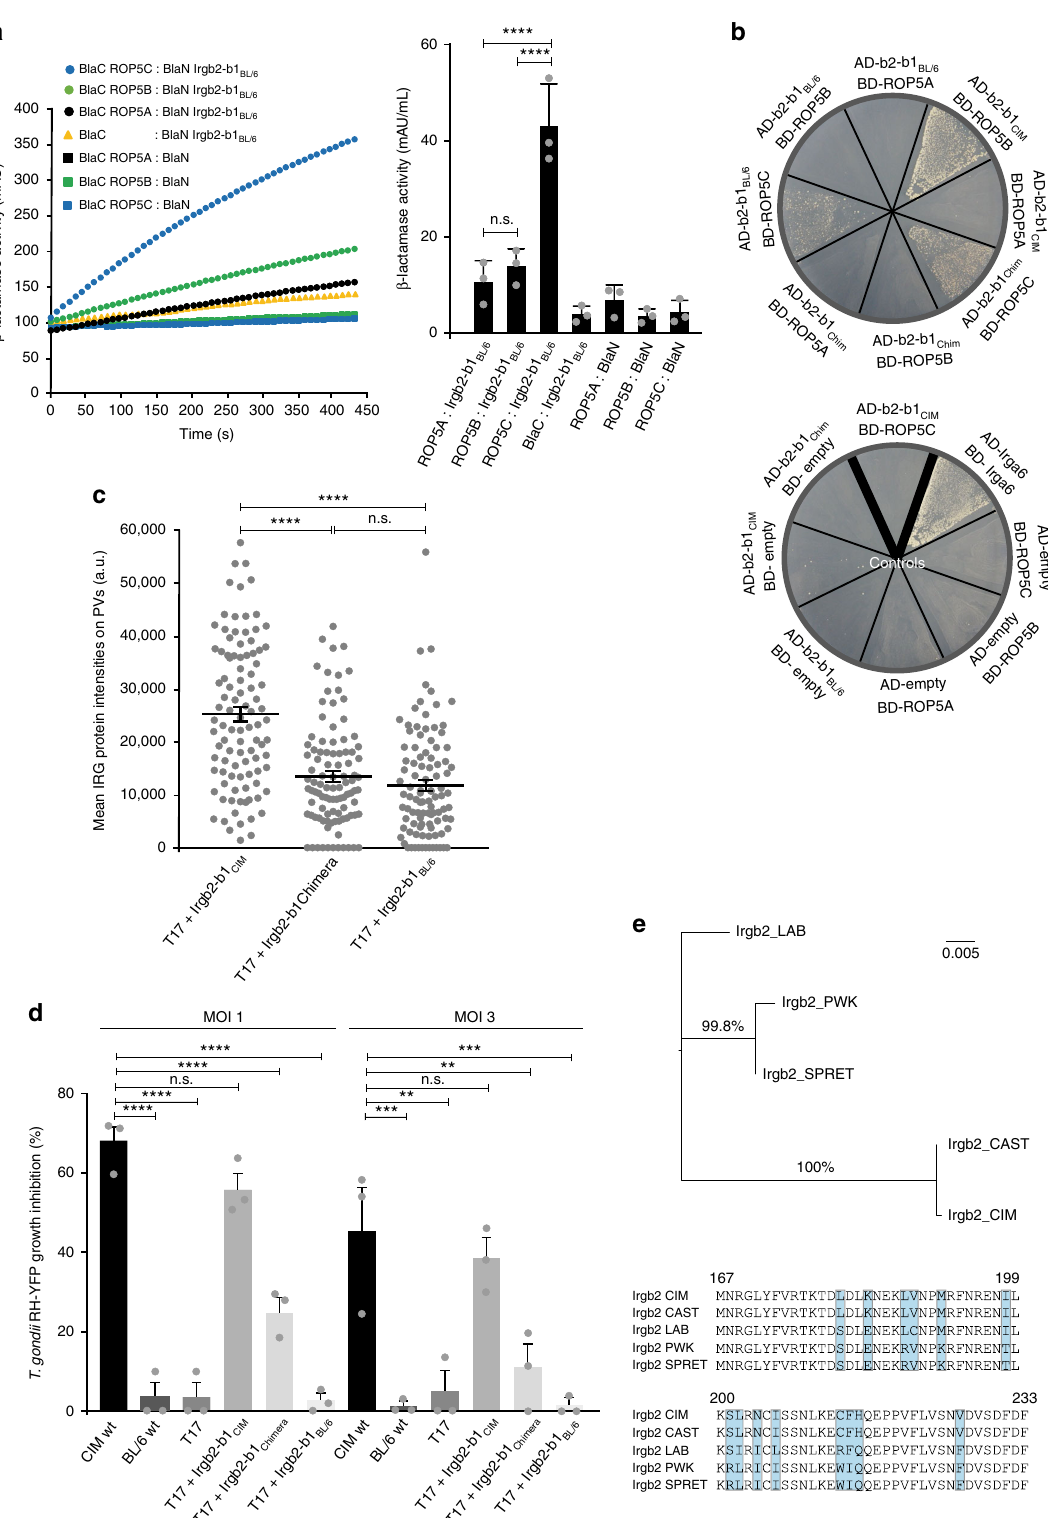
CIM cells, the absence of Irgb2-b1 CIM on the vacuole was asso- ciated with elevated levels of p(T108)Irga6 CIM . In case of AS28, the Irgb2-b1 CIM loading phenotype was intermediate between RH Δ hxgprt and VAND, but perhaps suf fi cient to account for the complete absence of Irga6 CIM phosphorylation (Fig. 6a, b). Consistently, limited binding of AS28-derived ROP5 to Irgb2-